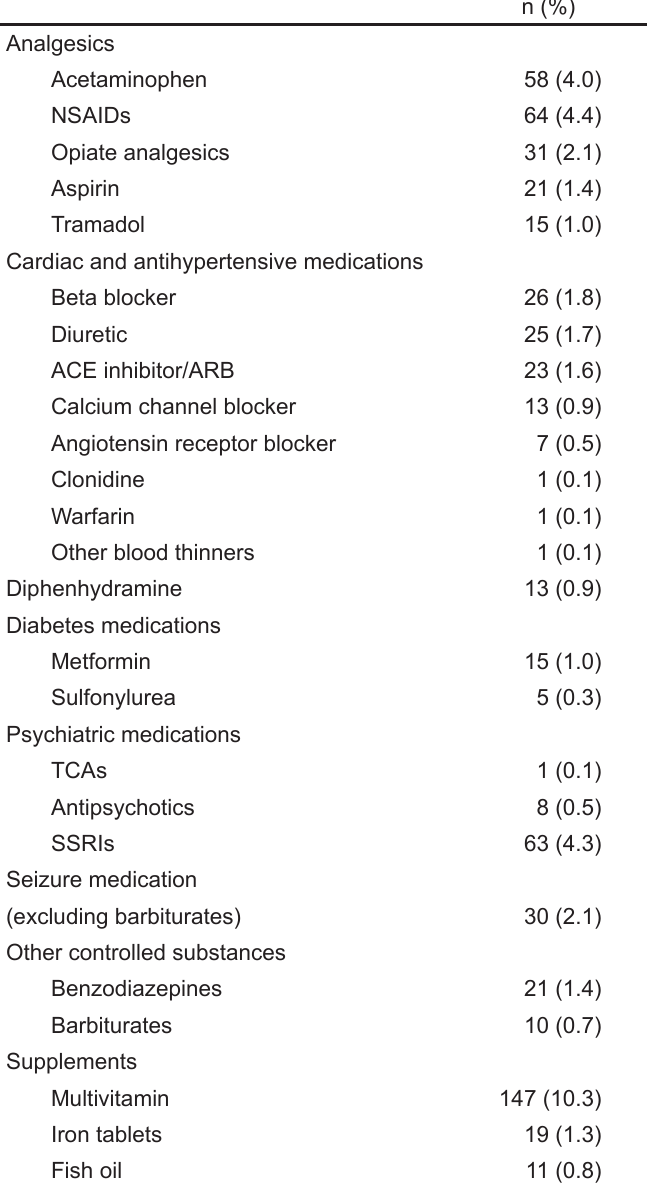
Table 2. Medications used by participants who live with the child